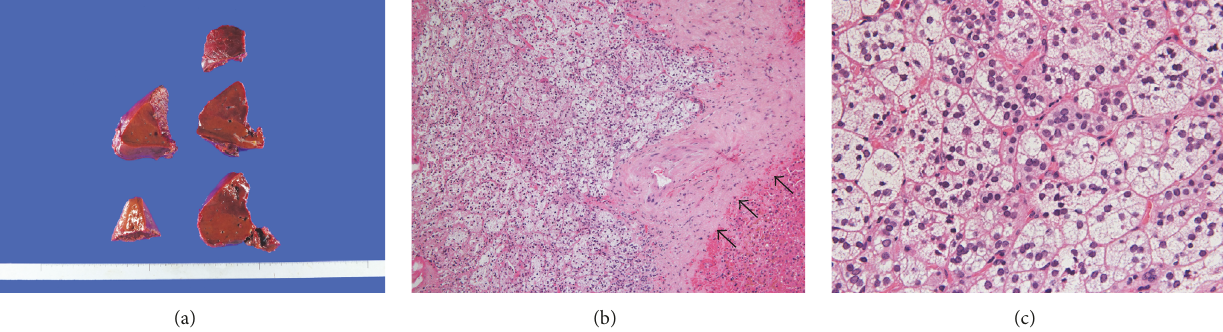
Figure 3: Macroscopic and pathological examinations. The lesion was not recognized by macroscopic examination of the cut surface of the surgically resected liver (a). Microscopically, the tumor is surrounded by the thin fibrous capsule (arrow) (b) (Hematoxylin and Eosin stain × 100). The lesion was composed of epithelioid cells with a microvesicular cytoplasm that formed nests or cords with abundant capillary vessels (c) (Hematoxylin and Eosin stain ×